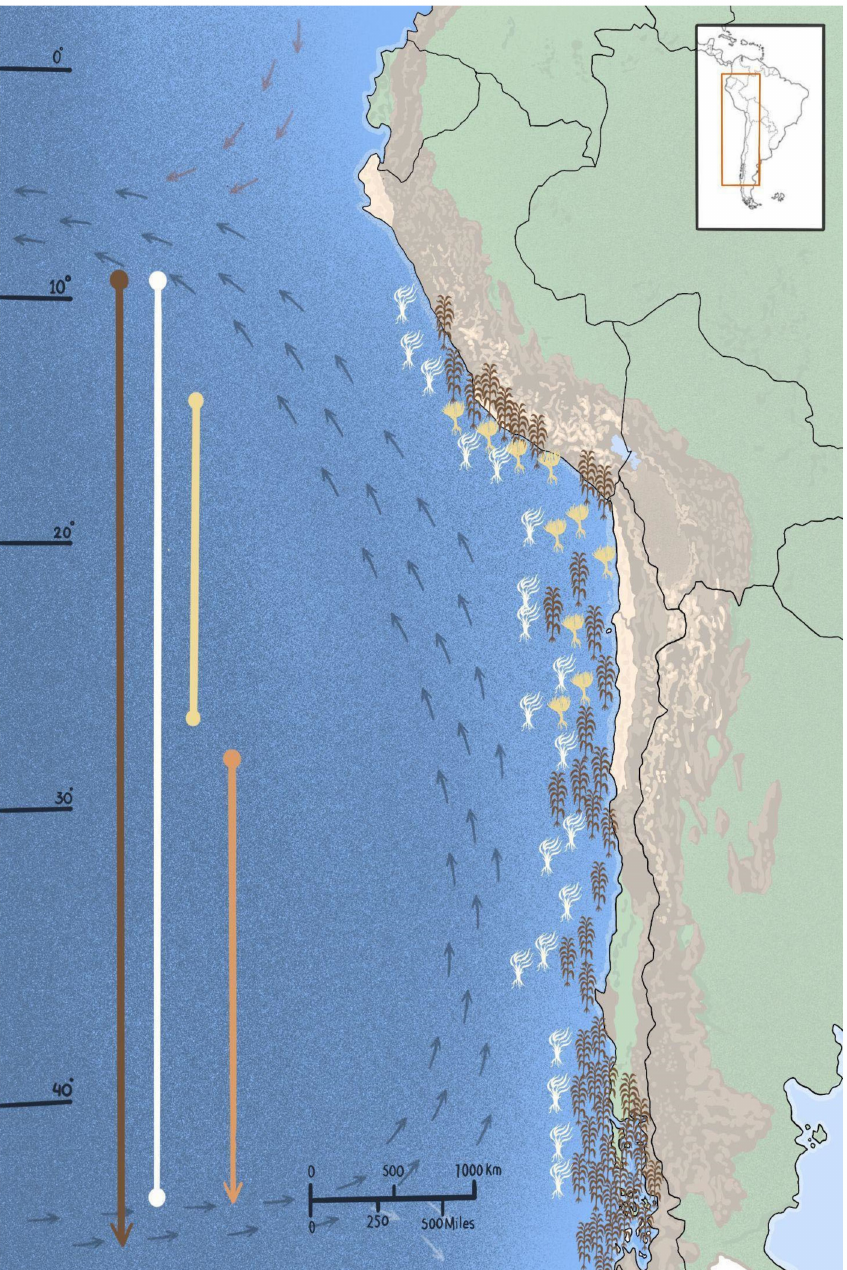
Figure 1. Distribution patterns of kelp species forming marine forests in the Humboldt Current System: Macrocysstis pyrifera (brown), Lessonia trabeculata (white), L. berteroana (yellow), and L. spicata